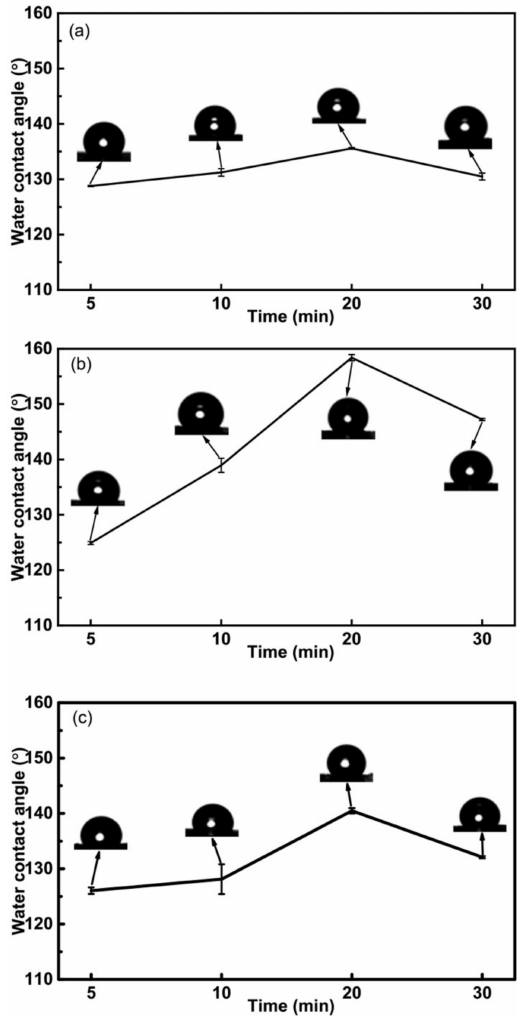
Figure 5. Contact angle measurements as a function of different electrodepositing times, using the following current densities: ( a ) 50 mA/cm 2 , ( b ) 100 mA/cm 2 , and ( c ) 200 mA/cm 2 . Reprinted from [73], with permission from Elsevier (November,